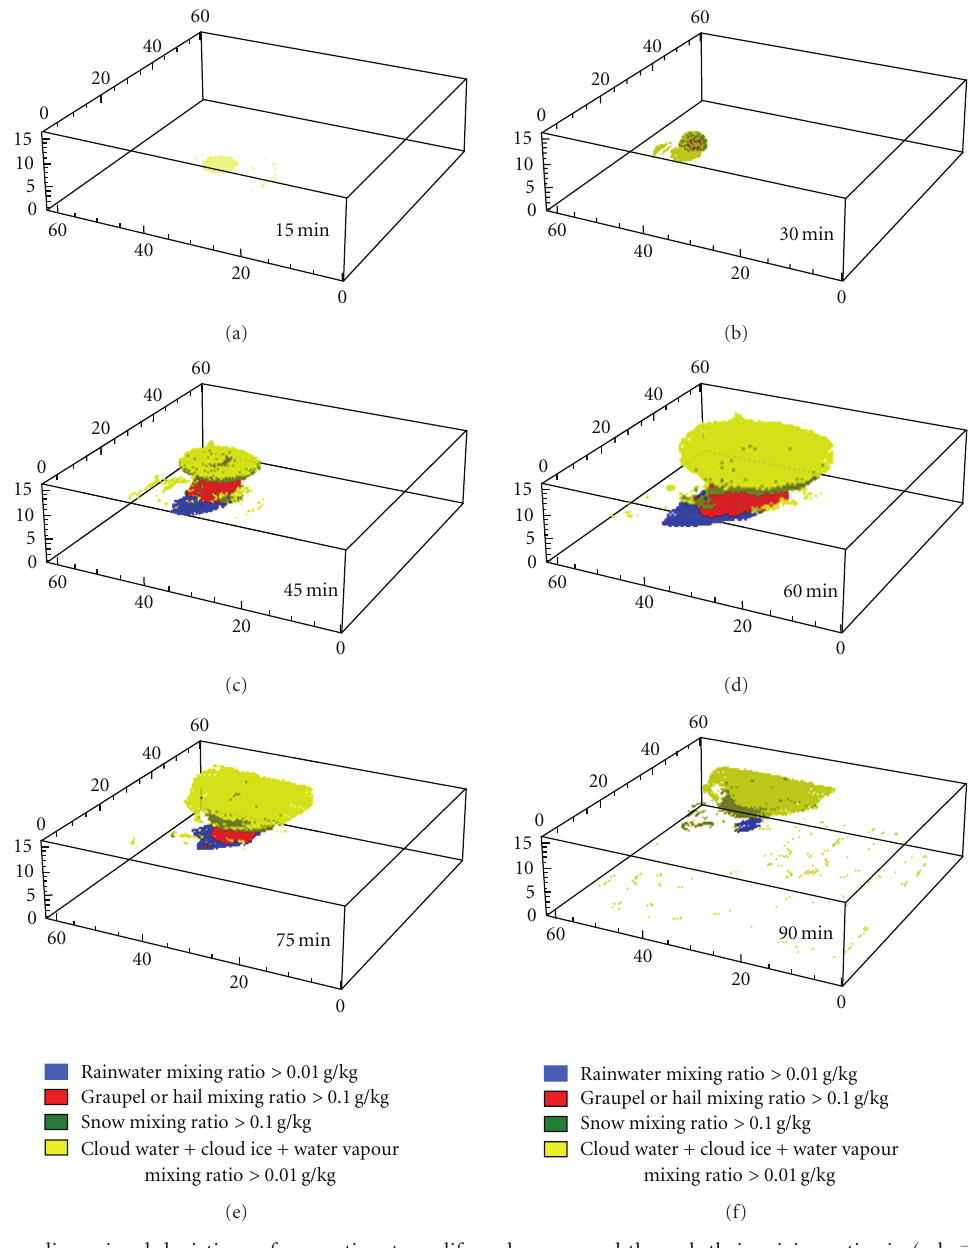
Figure 2: A three-dimensional depictions of convective storm life cycle, expressed through their mixing ratios in (g kg − 1 ), viewed from the southeast (SE), at 15-minute time intervals starting at 15 minutes. Plots with a corresponding yellow, blue, green, and red color denote the total condensate mixing ratios of cloud water, rainwater, snow, and hail, respectively. The model was run with a spatial resolution of (1 × 1 × 0 . 5) km 3 and a temporal resolution of